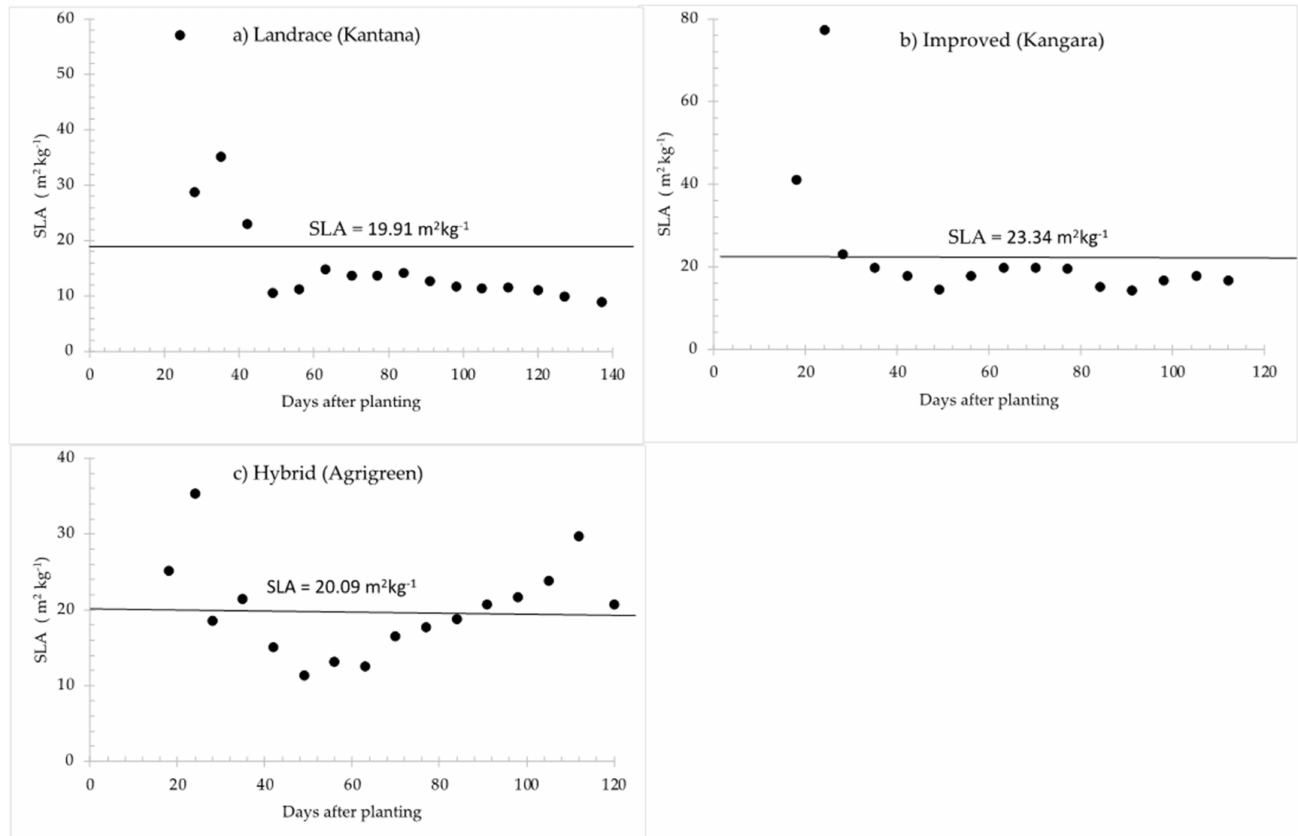
Figure 4. Measured values of specific leaf area (SLA) during the growing season of three pearl millet varieties: ( a ) landrace, ( b ) improved and ( c ) hybrid, the value shown on horizontal line is the average SLA for each